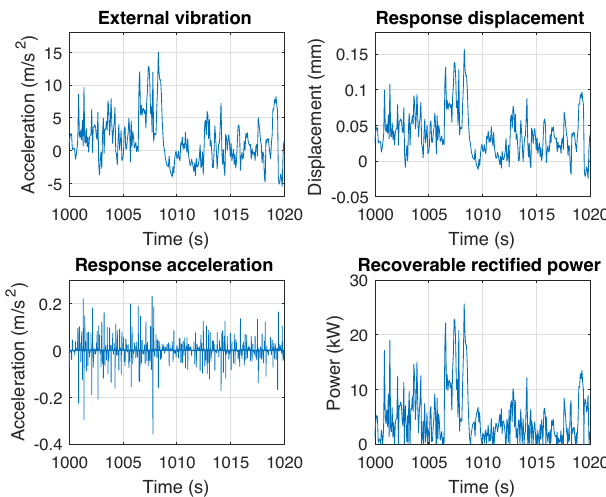
Figure 11. Zoomed view of external vibration and response from one electromagnetic suspension on a wheel based on measured data from real road conditions with a vehicle travelling at 50 km/h.